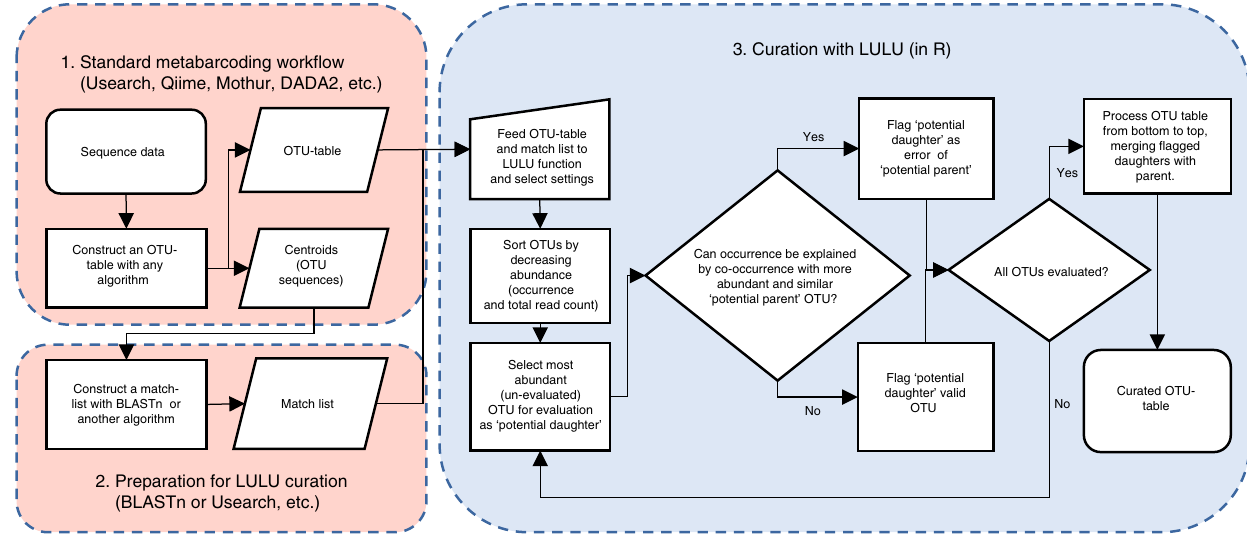
Fig. 2 LULU curation work fl ow. (1) The user constructs an OTU table. (2) The user constructs a match list. (3) OTU table and match list is fed to the